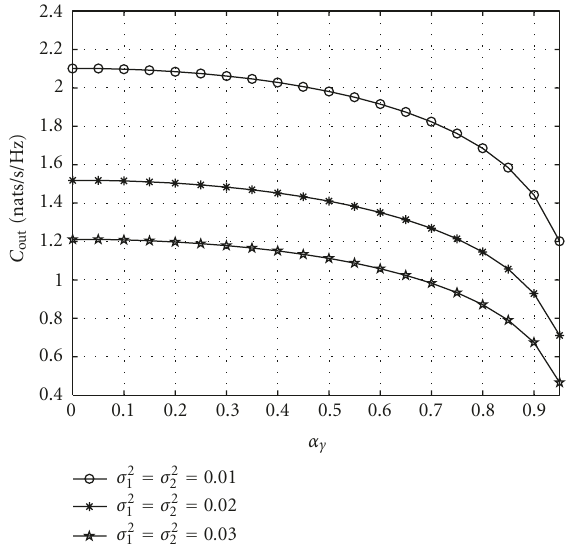
Figure 6: Lower bound on the outage capacity of D-STBCs with single receive antenna versus the channel gains variations at SNR = 15